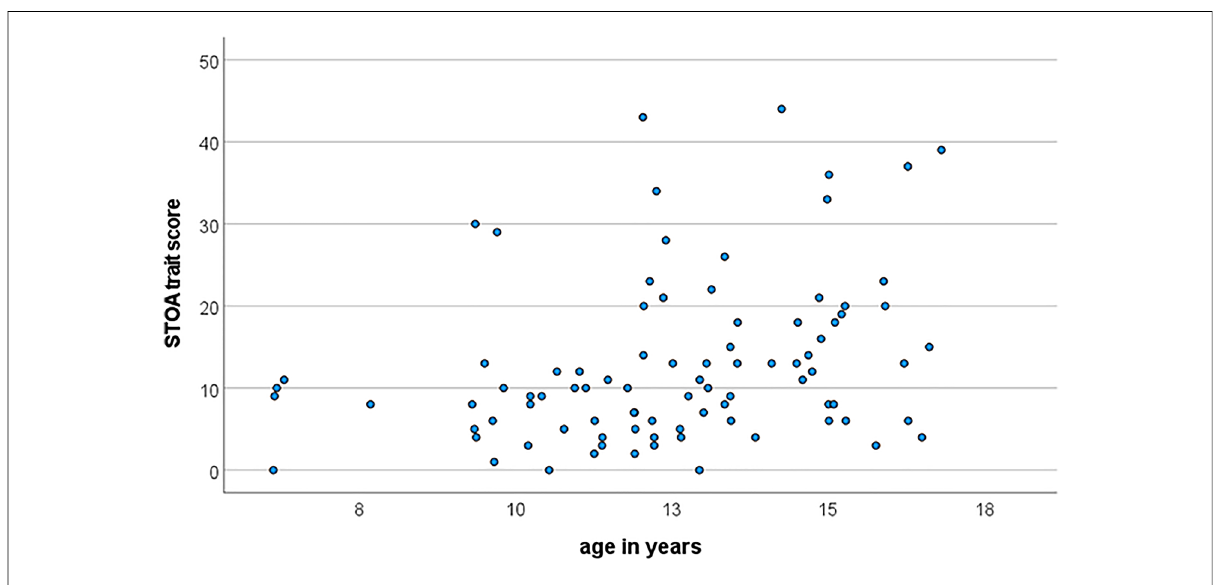
FIGURE 2 Association between age and STOA trait score in